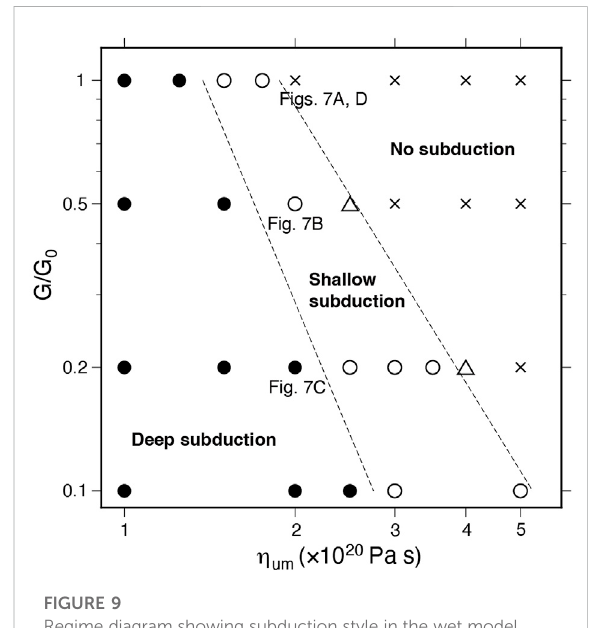
FIGURE 9 Regime diagram showing subduction style in the wet model as a function of upper mantle viscosity η um and G / G 0 . Solid circles indicate that the subducting plates reaches the deeper part of the upper mantle, whereas open circles indicate that the plate becomesstagnantintheshallowerpartoftheuppermantle(i.e.,at a depth of ~100 km). Crosses indicate that plate subduction does not occur, and open triangles represent intermediate regions between the subduction and no-subduction regimes. Dashed lines indicate the approximate boundaries between regimes with different subduction